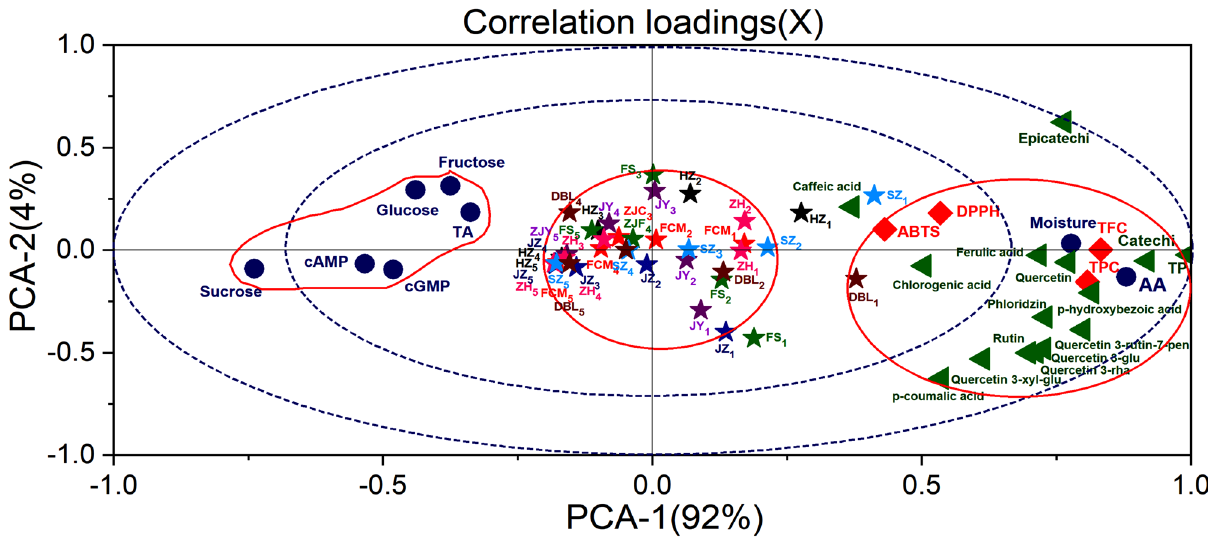
Figure 11. Correlation loading plots of principal component analysis